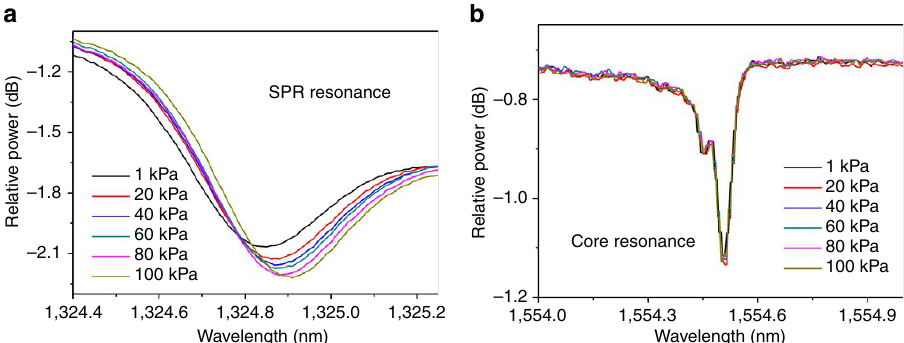
Figure 4 | Effect of atmospheric pressure changes on the resonances of interest of a gold-coated highly tilted FBG. ( a ) The evolution of an SPP- matched cladding mode resonance in response to strong changes of the atmospheric pressure. ( b ) Focuses on the core-mode resonance.